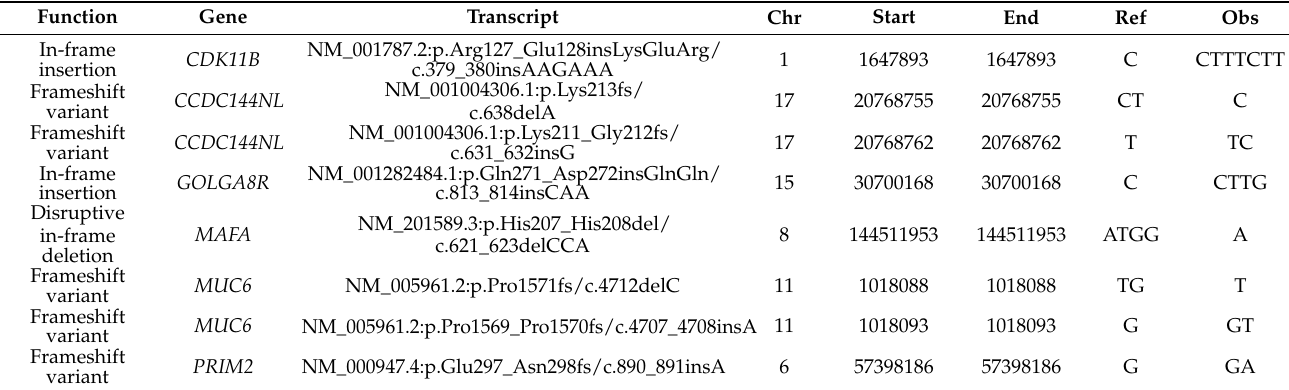
Table 4. Insertions and deletions identified in the seven whole-genome samples of CRC